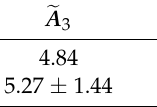
Table 5. Teaching performance rankings given by the evaluation method based on T1 FSs and the method of this study.